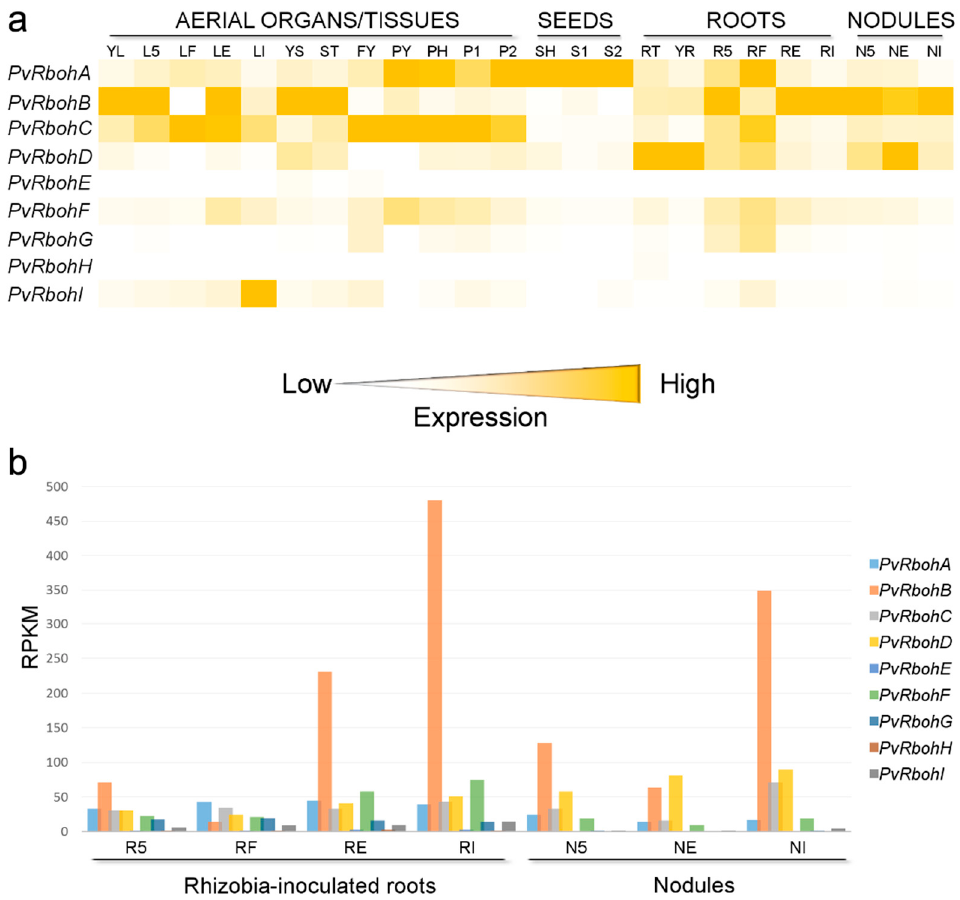
Figure 3. Expression profile of Rboh genes in different organs and tissues of P. vulgaris . ( a ) Heat map expression profiles highlight the most abundant Rboh transcripts in different organs and tissues of P. vulgaris ; ( b ) PvRboh expression under different conditions in rhizobia-inoculated roots and nodules; PvRbohB is predominantly expressed; nonetheless, other Rboh transcripts are expressed in nodules such as PvRbohA , PvRbohC , and PvRbohD . The expression analysis was assessed in the Phaseolus vulgaris Gene Expression Atlas [35,59]. YL—Fully expanded second trifoliate leaf tissue from plants provided with fertilizer; L5—Leaf tissue collected five days after plants were inoculated with effective rhizobium; LF—Leaf tissue from fertilized plants collected at the same time as LE and LI; LE—Leaf tissue collected 21 days after plants were inoculated with effective rhizobium; LI—Leaf tissue collected 21 days after plants were inoculated with ineffective rhizobium; YS—All stem internodes above the cotyledon collected at the second trifoliate stage; ST—Shoot tip, including the apical meristem, collected at the second trifoliate stage; FY—Young flowers, collected prior to floral emergence; PY—Young pods, collected 1 to 4 days after floral senescence. Samples contain developing embryos at the globular stage; PH—Pods approximately 9 cm long, associated with seeds at heart stage (pod only); P1—Pods between 10 and 11 cm long, associated with stage 1 seeds (pod only); P2—Pods between 12 and 13 cm long, associated with stage two seeds (pod only); SH—Heart stage seeds, between 3 and 4 mm across and approximately 7 mg; S1—Stage 1 seeds, between 6 and 7 mm across and approximately 50 mg; S2—Stage 2 seeds, between 8 and 10 mm across and between 140 and 150 mg; RT—Root tips, 0.5 cm of tissue, collected from fertilized plants at the second trifoliate stage of development.; YR—Whole roots, including root tips, collected at the second trifoliate stage of development; R5—Whole roots separated from five-day old pre-fixing nodules; RF—Whole roots from fertilized plants collected at the same time as RE and RI; RE—Whole roots separated from fix+ nodules collected 21 days after inoculation; RI—Whole roots separated from fix- nodules collected 21 days after inoculation; N5—Pre-fixing (effective) nodules collected five days after inoculation; NE—Effectively fixing nodules collected 21 days after inoculation; NI—Ineffectively fixing nodules collected 21 days after inoculation.